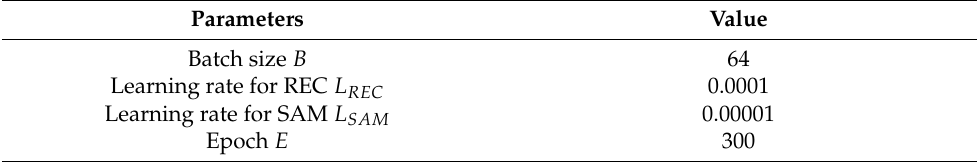
Table 3. Summary of training hyperparameter